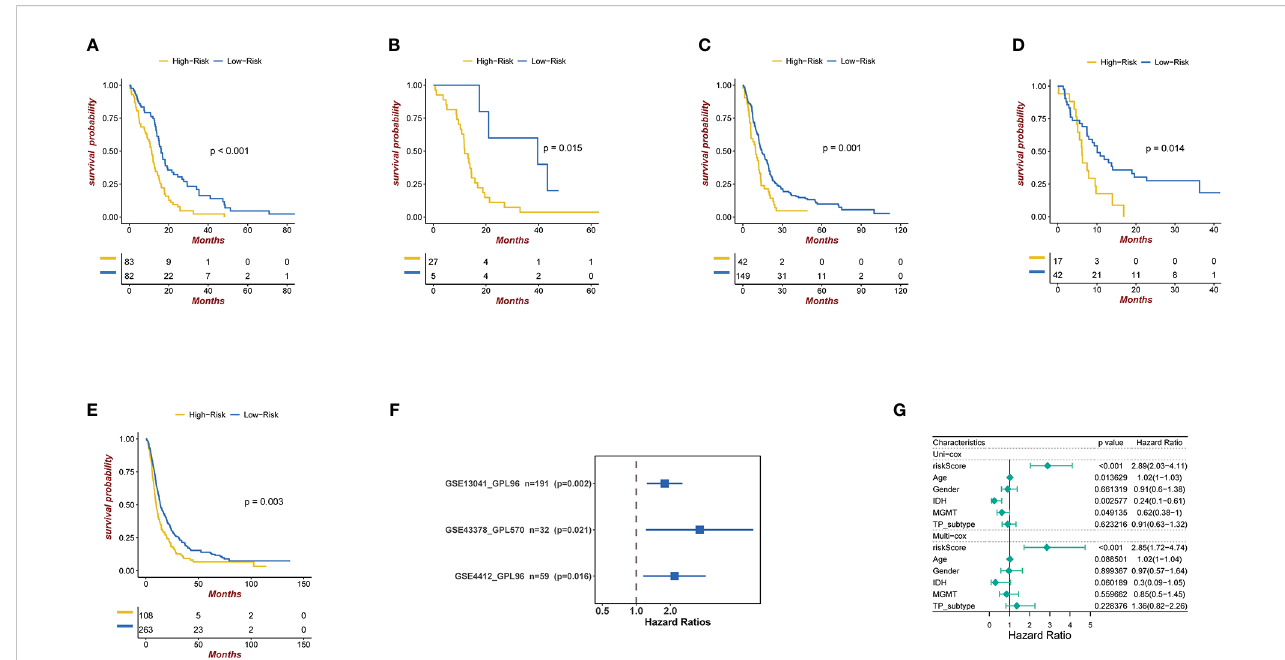
FIGURE 3 (A) Kaplan-Meier curves for the TCGA patient groups with high and low risk scores. Test of log-rank, P< 0.001. (B-D) Kaplan-Meier curves in GSE4412, GSE13041, and GSE43378 for patient groups with high and low risk scores. Test of log-rank, P<0.001. (E) Kaplan-Meier curves for the CGGA patient groups with high and low risk scores. Test of log-rank, P< 0.05. (F) Univariate cox regression analyses analysis to assess the clinical prognostic value of independent glioma datasets in low/high risk groups. The hazard-ratio scale is log2 scaled. (G) Univariate and multivariate analysis regression analysis evaluates the clinical prognostic value of independent glioma datasets in low/high risk